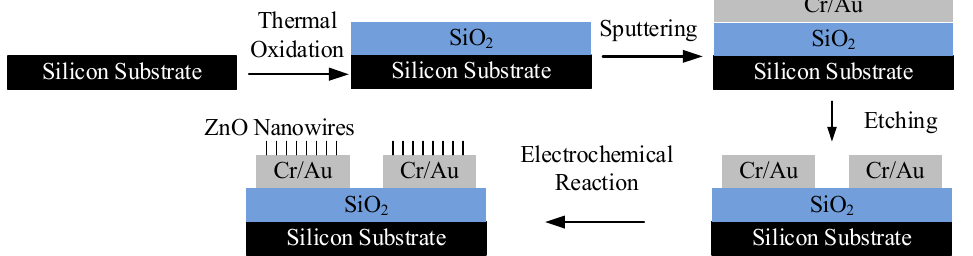
Figure 6. The fabrication process of ZnO nanowires on microelectrodes.